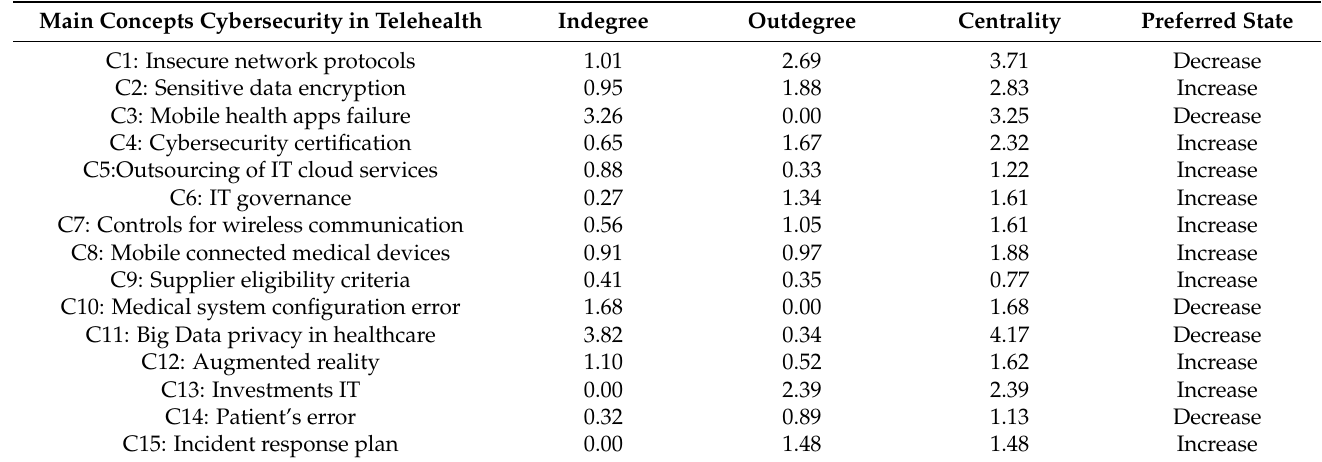
Table 2. Degree of the centrality of IT manager preference concepts.